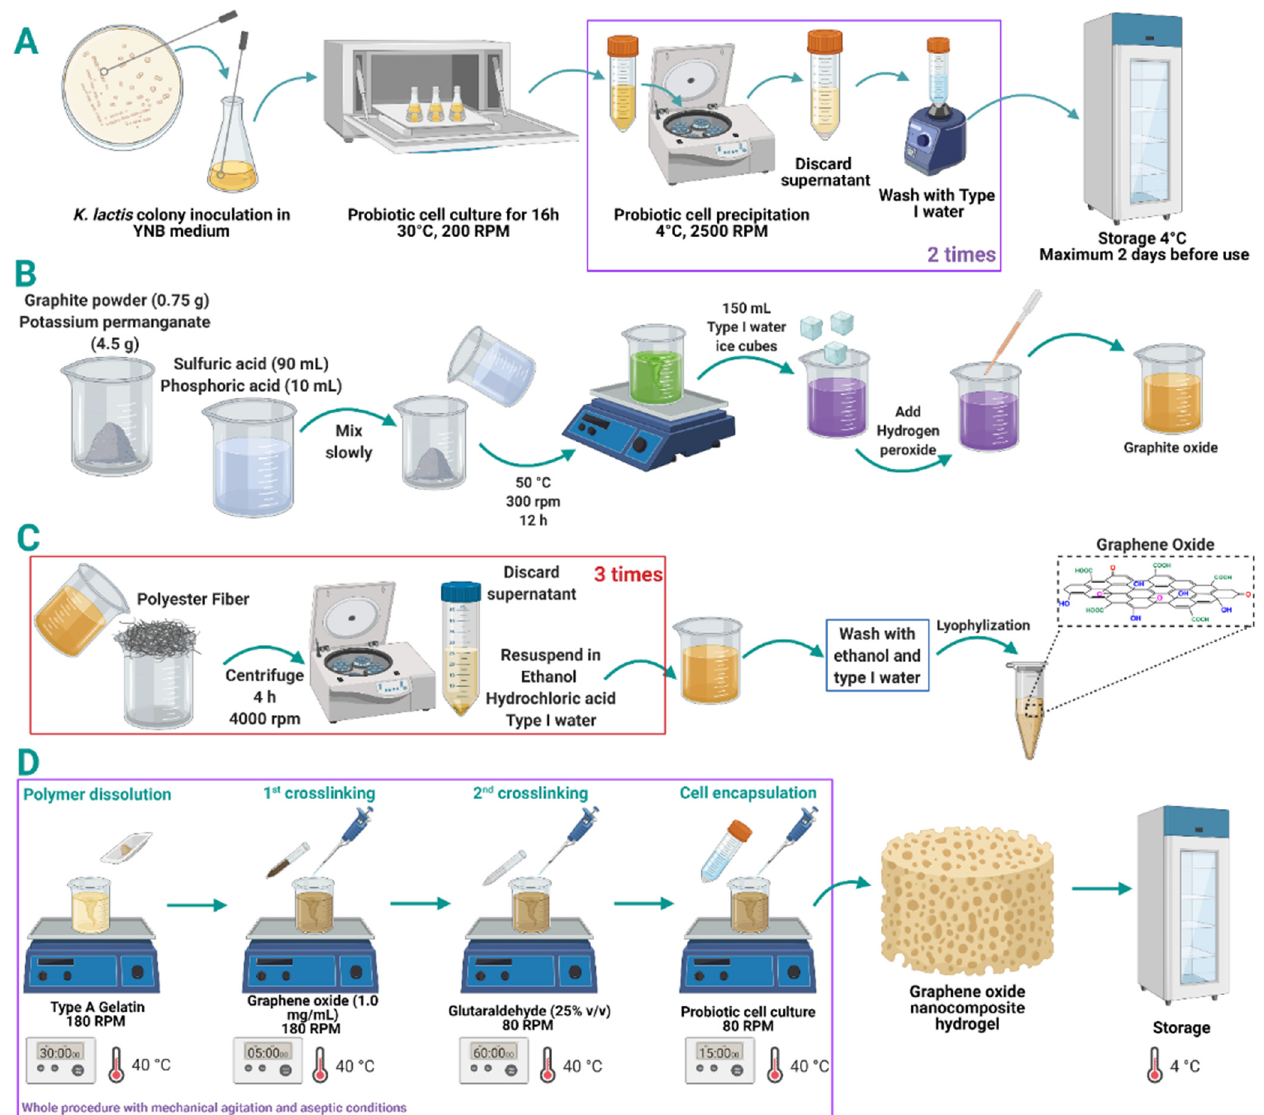
Figure 1. K. lactis cell inoculation, culture, washing, and storage for graphene oxide (GO) nanocomposite hydrogels encapsulation ( A ). Synthesis of GO through the modified Tour’s method. ( B ) Oxidation reaction and ( C ) washing process. Protocol for encapsulation of K. lactis probiotic cells in the matrix of gelatin-GO nanocomposite hydrogels ( D ).